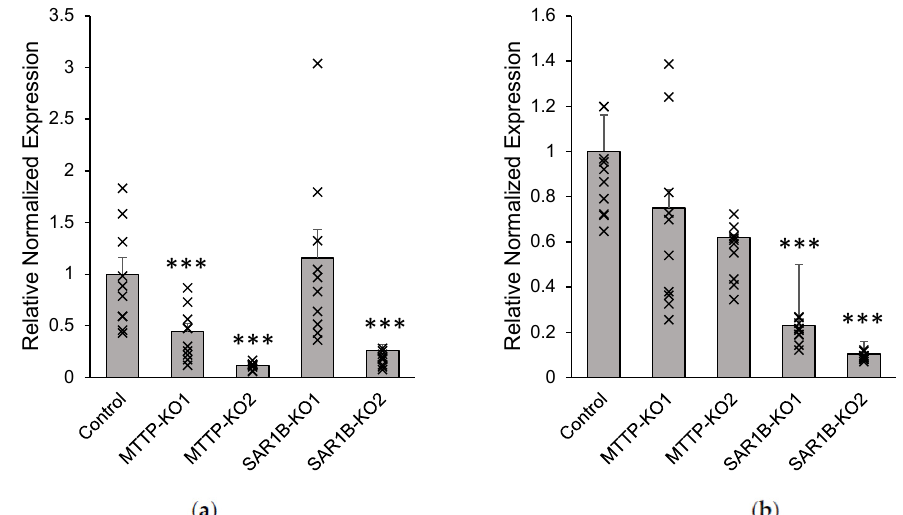
Figure 4. Gene expression measured by RT-qPCR in Caco-2/TC7 cells following CRISPR/Cas9 knock-out. Cellswereculturedoninsertsfor21days. ( a ) MTTP and( b ) SAR1B mRNAexpressiondeterminedbyRT-qPCR in two clones lacking MTP and two clones lacking Sar1b proteins (as seen on Western blots). Wild-type cells’ mRNA levels were assigned a value of 1. and MTTP - or SAR1B -KO mRNA levels are expressed as relative expressions to wild-type cells. Data are expressed as means SEM ( n = 10). Asterisks indicate a statistically ± significant difference in gene expression levels between control and KO clones (*** p <